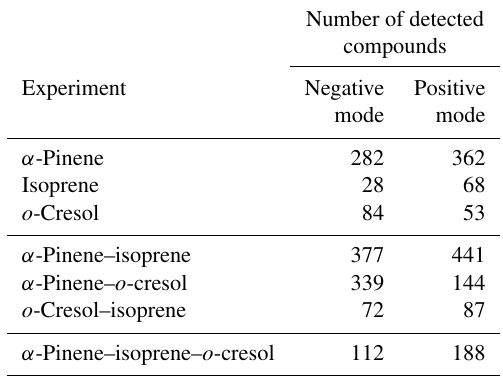
Table 2. Number of compounds detected in an SOA sample in neg- ative and positive ionization mode from single, binary, and ternary precursor